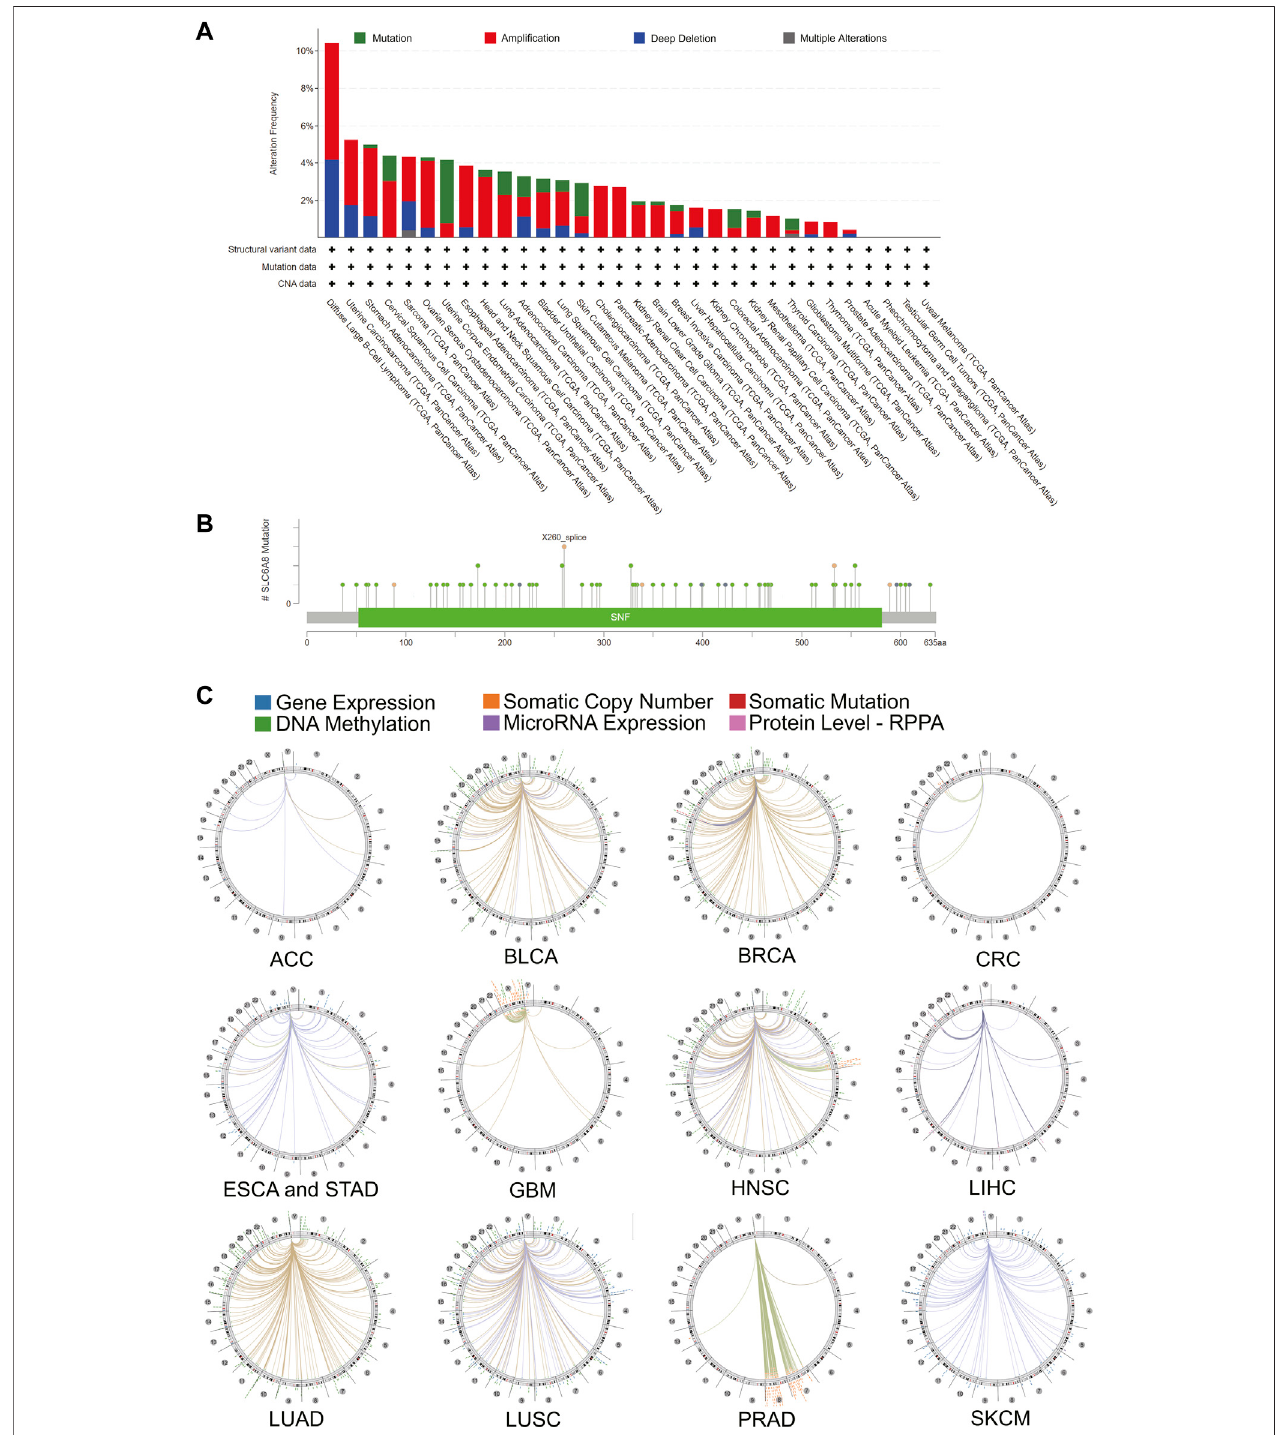
FIGURE5| MutationallandscapeofSLC6A8anditsassociationwithgenomeincancers. (A) SLC6A8 genealterationfrequencyacrosscancers. (B) Mutationsites of SLC6A8 in pan-cancer. (C) The correlation between SLC6A8 and other signatures of genome based on TCGA data.